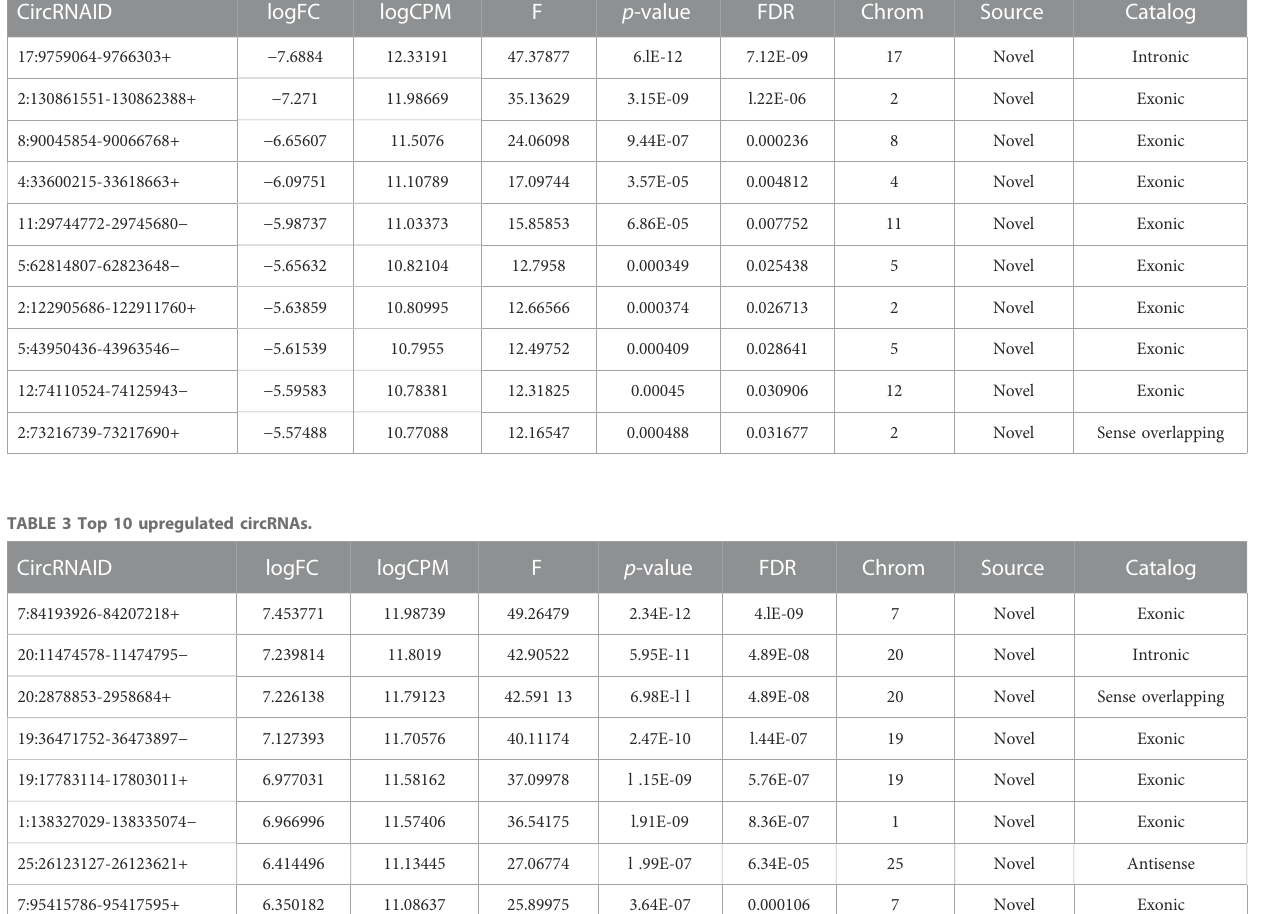
TABLE 2 Top 10 signi fi cantly downregulated circRNAs. CircRNAID